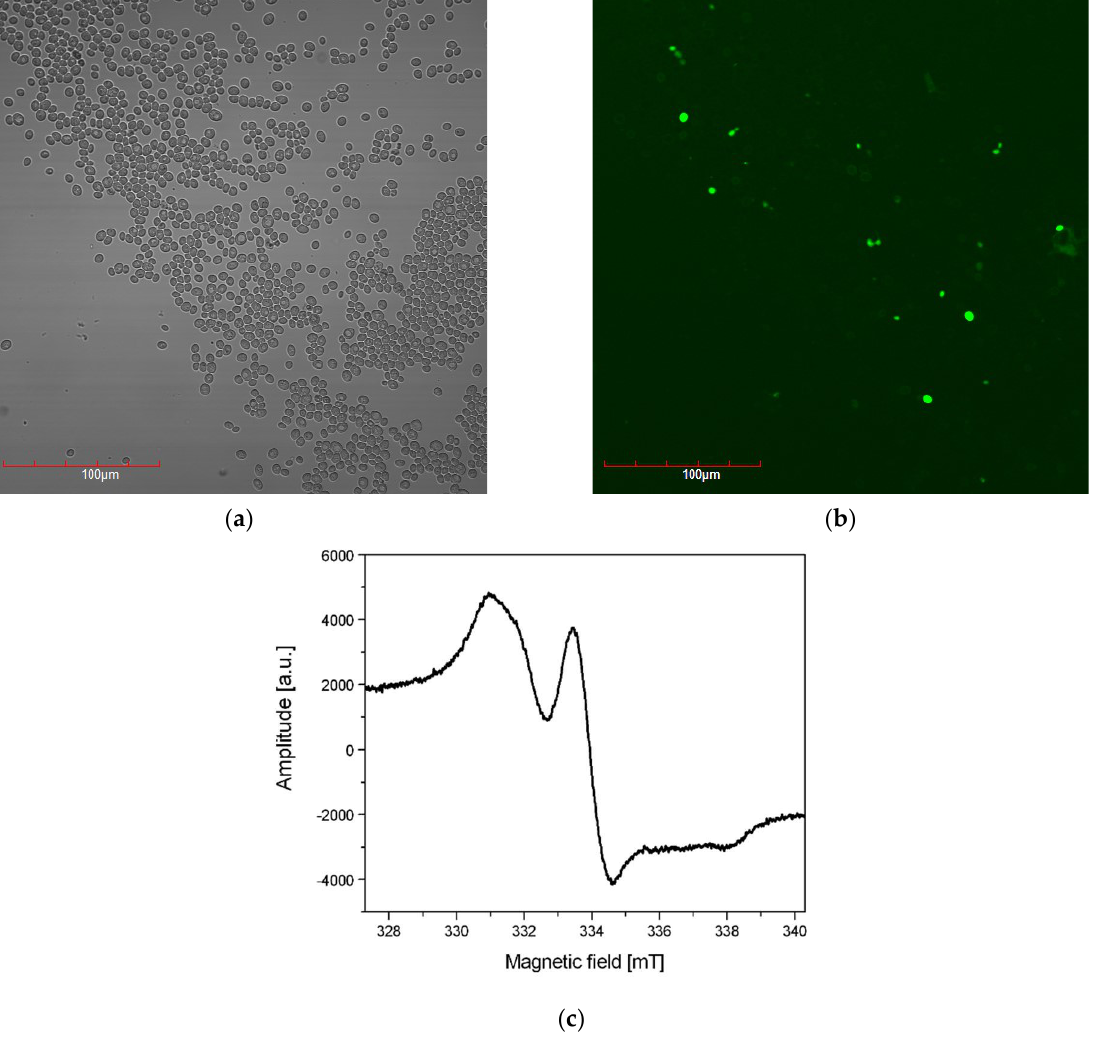
Figure 4. Confocal fluorescent imaging of TEMPO–Fluorescein with yeast cells ( a , b ) and the corresponding ESR spectrum ( c ) after 2 h of incubation.